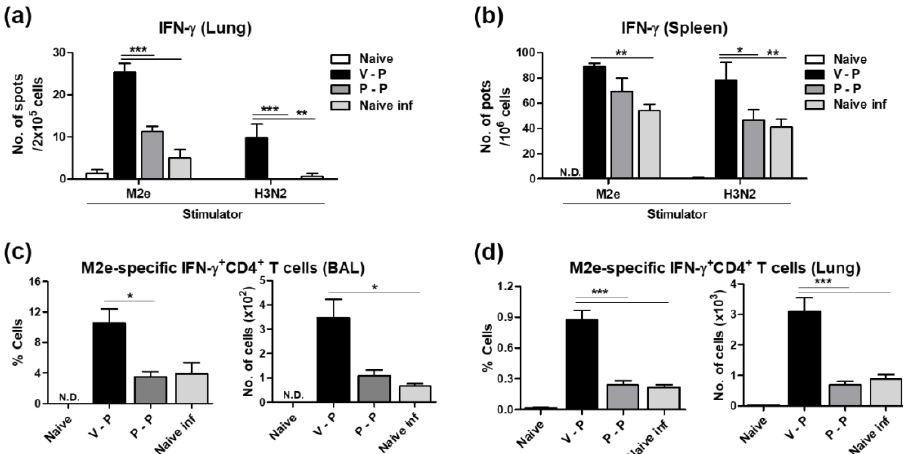
Figure 6. VLP prime is superior to protein prime in inducing antigen-specific T cells producing IFN- γ. The cells were harvested from the spleen and lungs of immunized mice 6 dpi (A/Phil, H3N2). ( a , b ) The spots producing IFN-γ were determined by culture for 2 days in the presence of M2e peptide or H3N2 virus antigen using ELISpot analysis. The data were obtained from averages of pooled samples with triplicates of each group. ( c , d ) The CD4 T cells producing IFN-γ were determined after culture for 5 h in the presence of M2e peptide. Antigen-specific T cells were detected by intracellular cytokine staining with anti-IFN-γ, anti-CD4 antibody. The group labels are the same as in the Figure 3. The statistical significance was confirmed by two-way ANOVA and a Bonferroni post-test or one-way ANOVA and Dunnett’s multiple comparison test. Error bars indicate the means ± SEM of cellularity from individual animals. *; p < 0.05, **; p < 0.01, ***; p < 0.001.